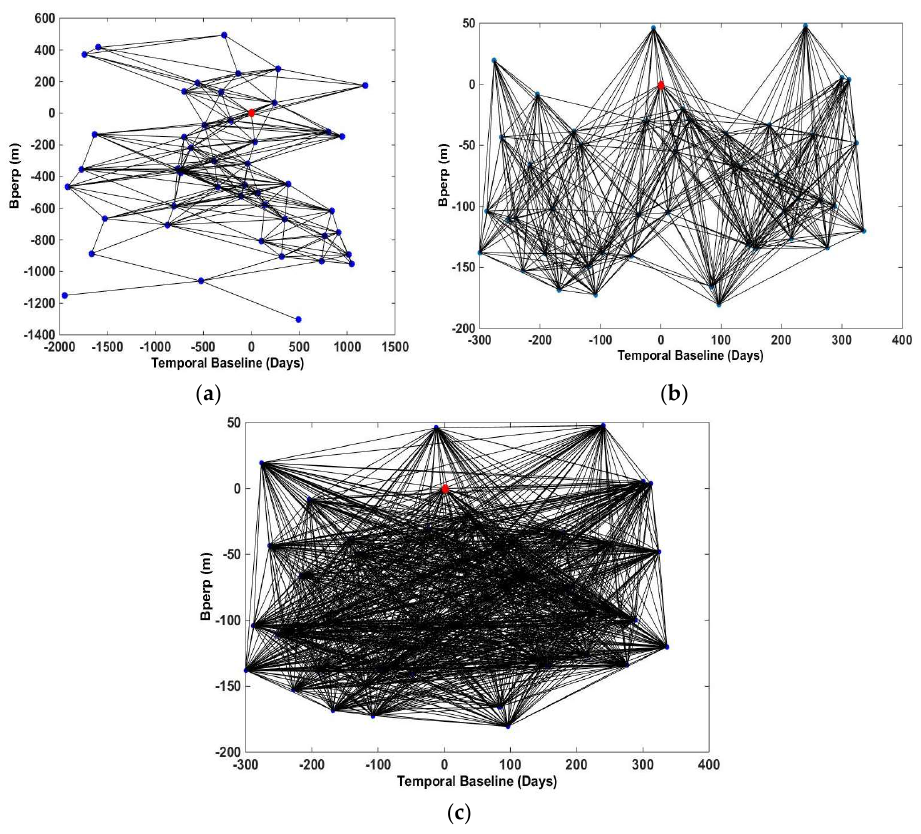
Figure 4. Perpendicular and temporal baselines of the image pairs relative to the master scene ( a ) ERS SAR (master: 1 September 1997) ( b , c ) Sentinel-1 SAR six-month and two-year temporal baselines, respectively (master: 6 January 2016). The red point is the master SAR image.